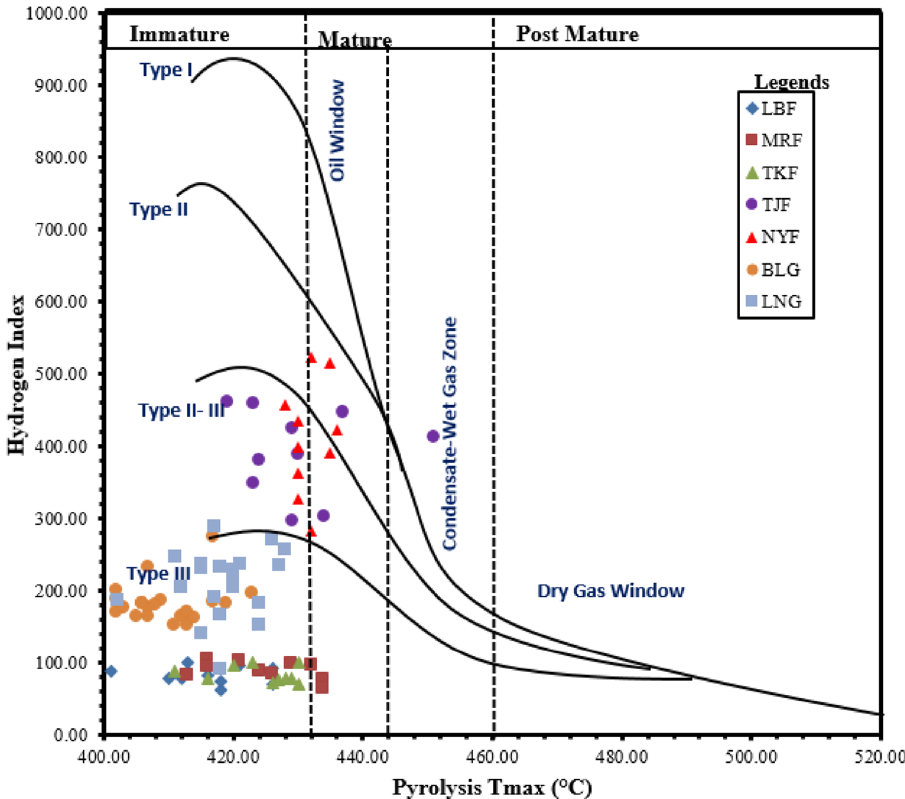
Fig. 11 Plot of hydrogen index against pyrolysis T Max for sam- ples ( n = 95) representing LBF Lambir, MRF Miri, TKF Tukau, TJF Tanjong, NYF Nyalau, BLG Balingian and LNG Liang formations. Note the dominance of NYF and TJF samples plot- ted between Type II and Types II–III. Also note few samples of the NYF, TJF, MRF, and TKF in/around the oil window Plotted data were sourced from Hakimi and Abdullah (2013), Hakimi et al. (2013a, b), and Togunwa et al.